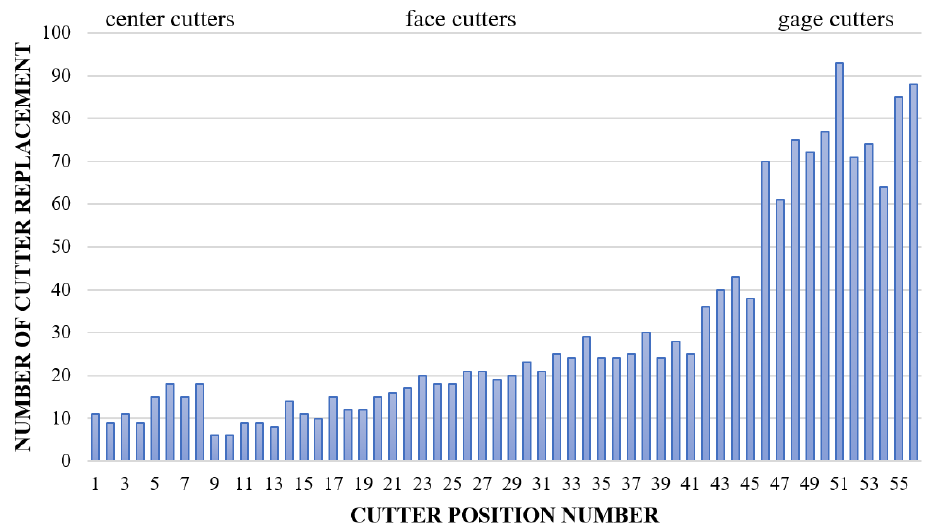
Figure 5. Number of disc cutter replacements at each position.